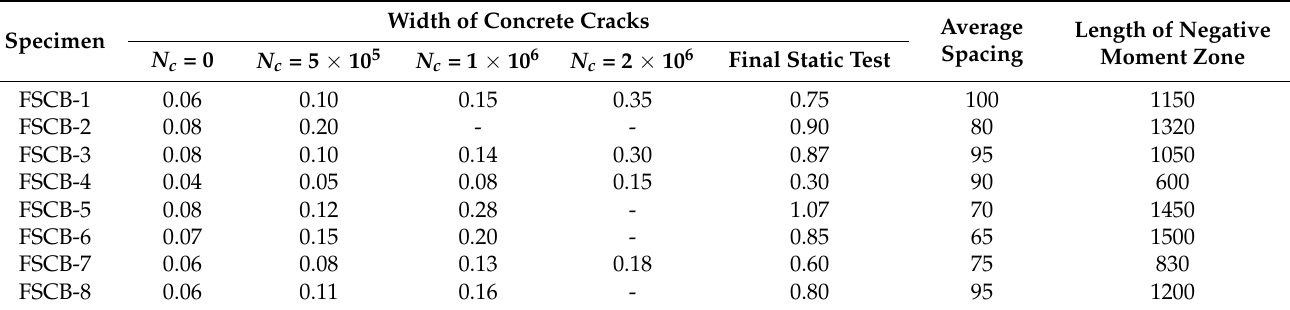
Table 4. The development of concrete cracks (unit: mm).